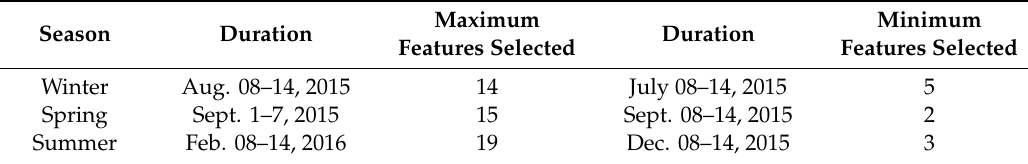
Table 4. Maximum and minimum number of features selected in all